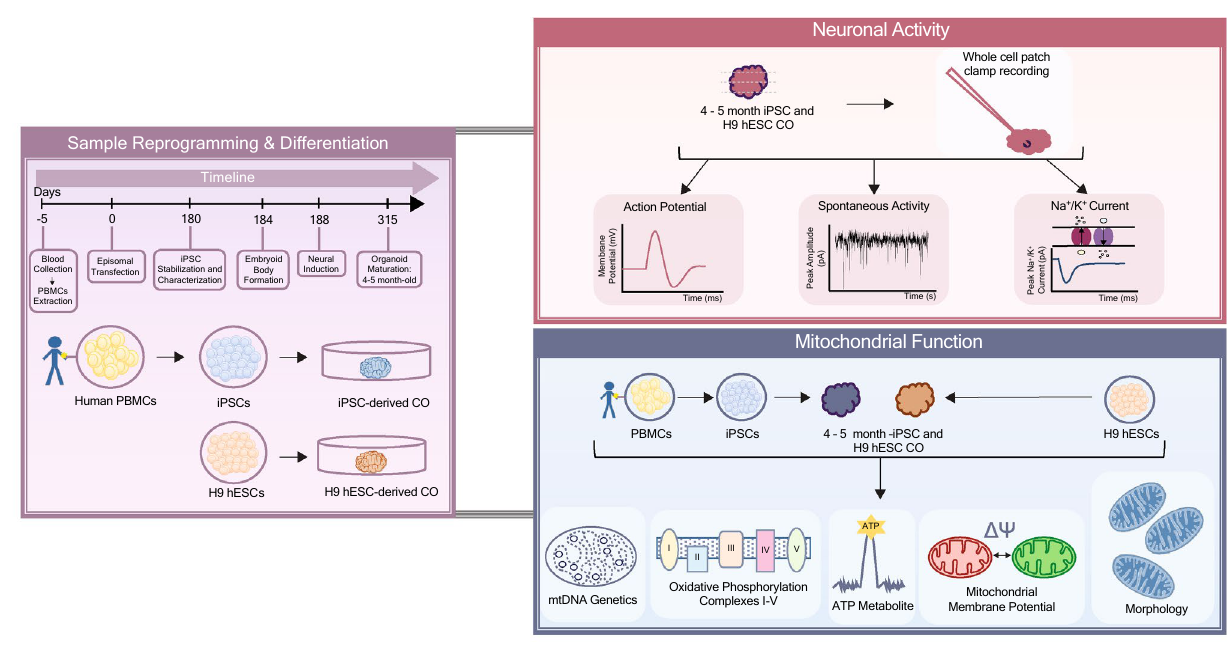
Figure 1. Schematic summary of the study design. Purple panel: An overview and a timeline of sample reprogramming and differentiation from peripheral blood mononuclear cells (PBMCs) to induced pluripotent stem cells (iPSCs) to cerebral organoids (COs) or H9 human embryonic stem cells (H9 hESCs) to COs. Red panel: An overview of electrophysiology experiments (action potentials, spontaneous activity, and sodium and potassium currents) in cerebral organoids. Blue panel: An overview of mitochondrial (mt-) genetics (mtDNA haplogroup, heteroplasmy and copy number), function (oxidative phosphorylation, ATP production and mitochondrial membrane potential) and morphology assessment across PBMCs to iPSCs to COs or H9 hESCs to